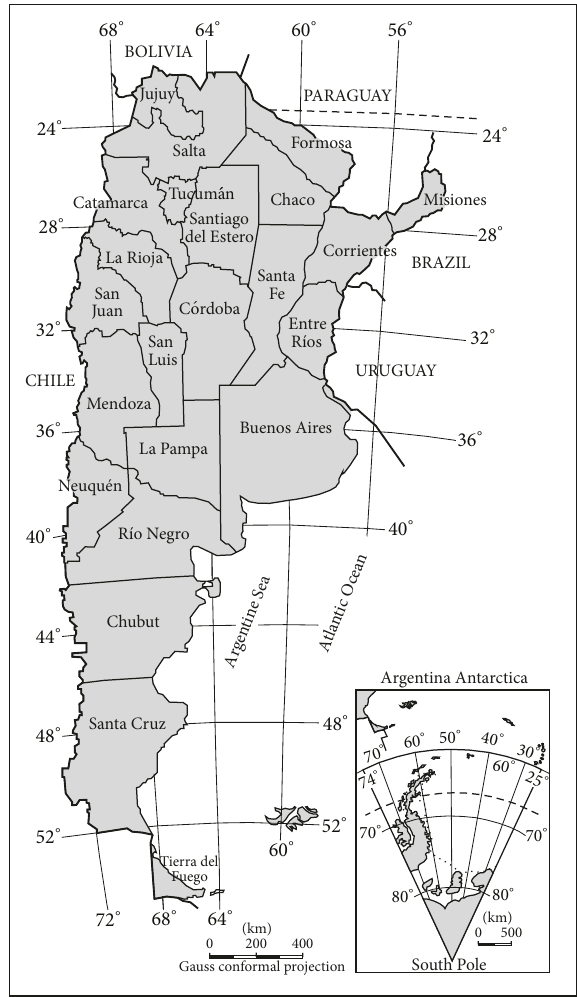
Figure 1: Argentina’s political